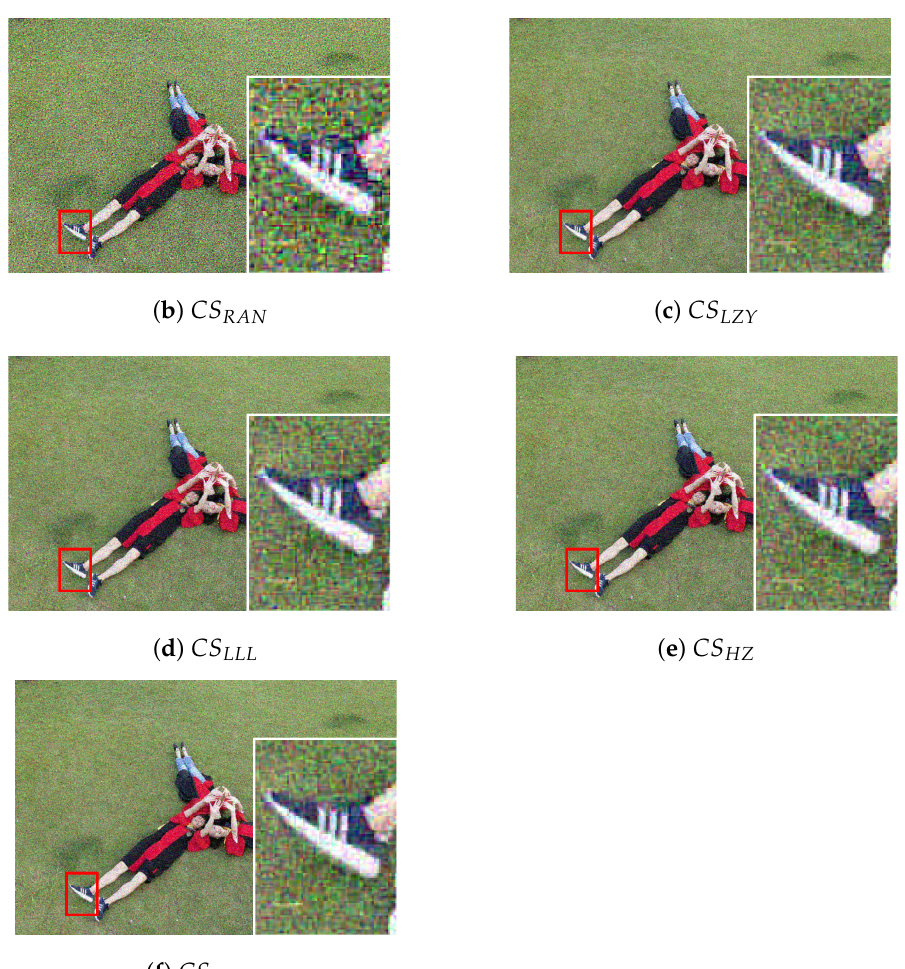
Figure 8. Recovery results for the UAV image "friends" taken by ourselves with noise ( SNR = 10 dB). ( a ) is the original image, ( a1 ) is the image with noise, ( b ) is the CS RAN algorithm, ( c ) is the CS LZY algorithm, ( d ) is the CS LLL algorithm, ( e ) is the CS HZ algorithm, and ( f ) is the CS LESM